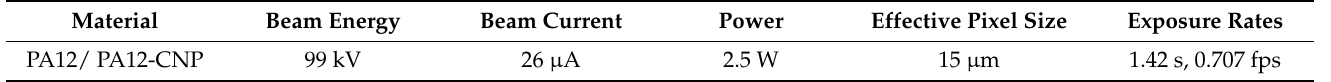
Table 1. Scanning parameters for the computed tomography scans ( µ